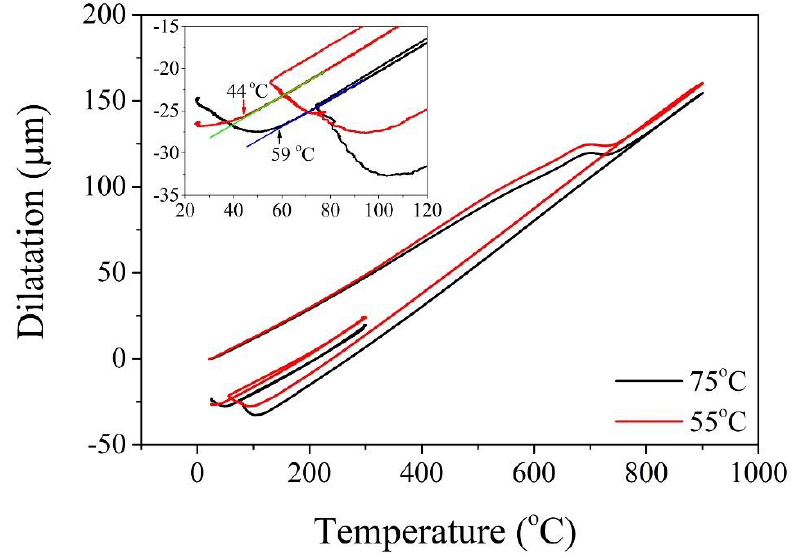
Figure 11. Dilation–temperature curves of medium Mn steel (Fe-8Mn-0.25C in wt.%) subjected to the quenching and partitioning process. The quenching temperature (QT) is either 55 °C or 75 °C, while the partitioning is at 300 °C with a duration of 60 s. The M s temperature decreases after partitioning in comparison with the quenching temperature, confirming the partitioning of C from martensite to austenite.